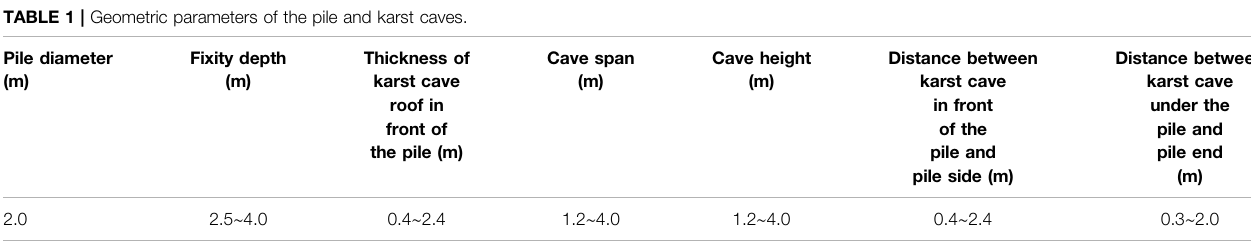
TABLE 1 | Geometric parameters of the pile and karst